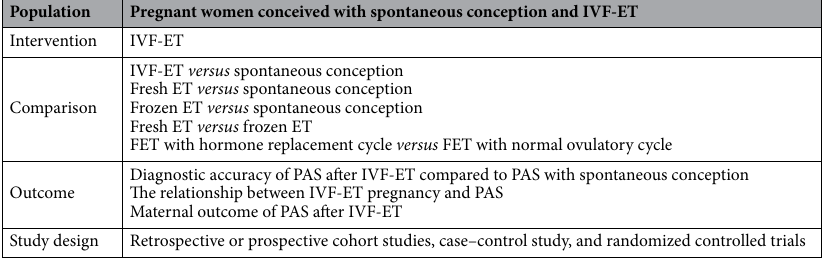
Table 1. PICOS criteria for inclusion of systematic review. PICOS patient/population, intervention, comparator, outcome, study, PAS placenta accreta spectrum, IVF-ET in vitro fertilization-embryo transfer, ET embryo transfer, FET frozen